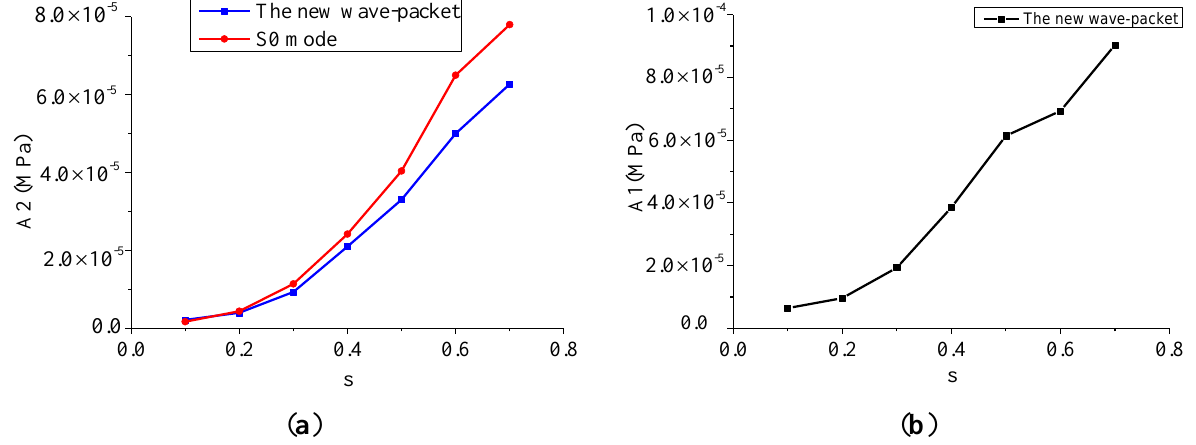
the variation of the amplitude ratio with micro-crack length severity had the same increasing trend as the amplitude of the second harmonic component of the S0 mode wave-packet. Figure 13. ( a ) Relationship between the amplitude of the second harmonic component and the micro-crack length severity for both the S0 mode wave-packet and the new wave-packet. The red curve represents the relationship for the S0 mode wave-packet, and the blue curve represents the relationship for the new wave-packet; A2 represents the amplitude of the second harmonic component; s represents the micro-crack length severity. ( b ) The relationship between the amplitude of the fundamental frequency component and the micro-crack length severity for the new wave-packet. A1 represents the amplitude of the fundamental frequency component; s represents the micro-crack length severity.